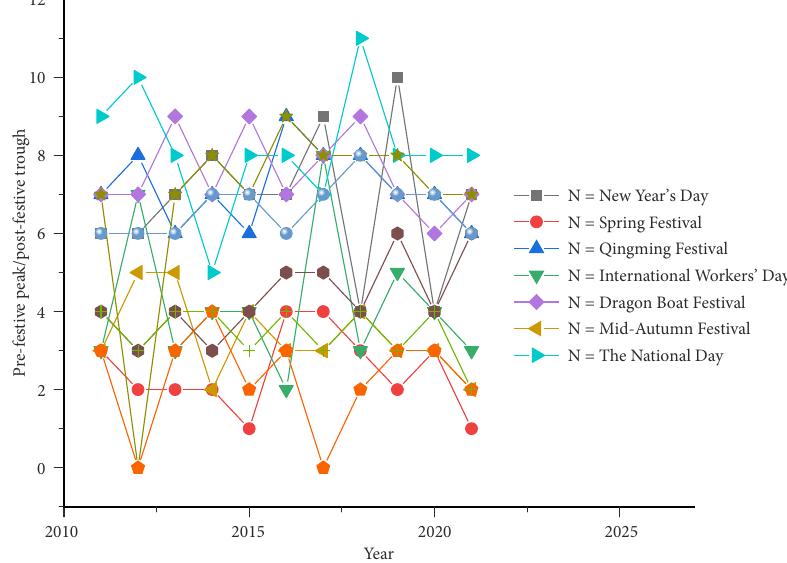
Figure 9. OPA to IST during national holidays (n refers to national holidays)